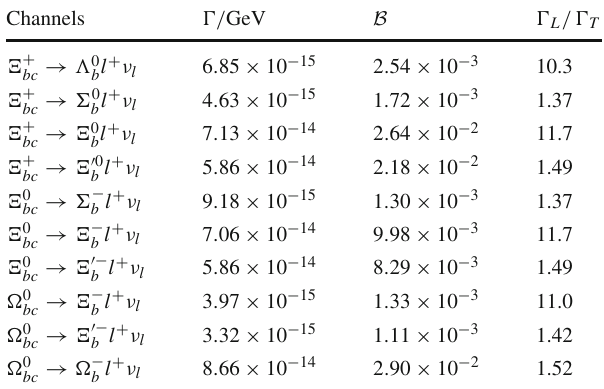
Table 18 The bc sector with the c quark decay and an axial vector bc diquark in the initial state: decay widths, branching ratios and the (cid:14) /(cid:14) L T for semileptonic decays, with lepton mass neglected